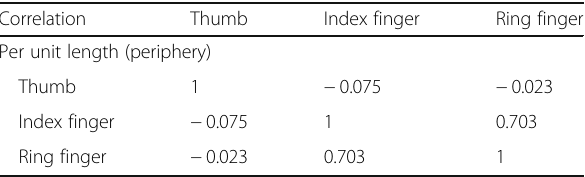
Table 7 Correlation between Thumb, Index, and Ring finger per unit area for periphery position